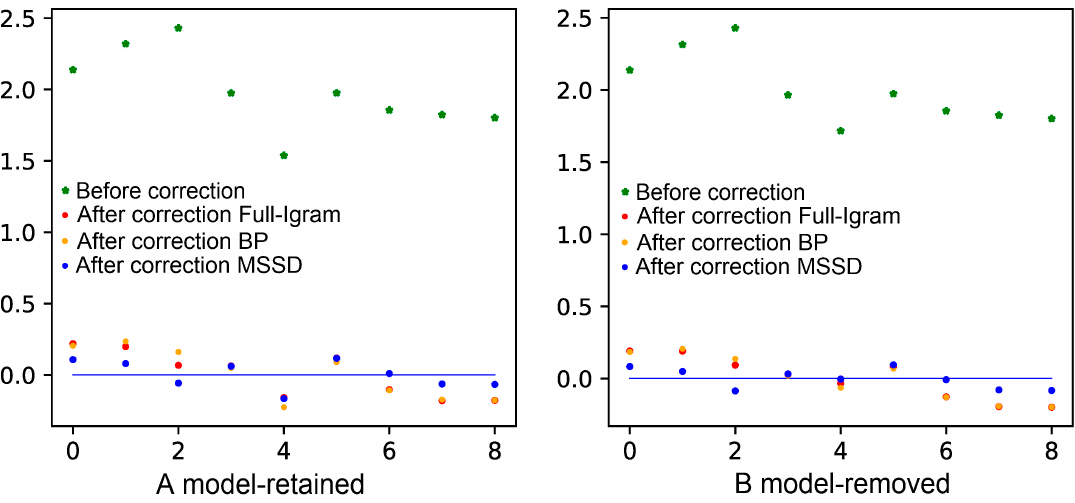
Figure 13. Correlation coe ffi cients of 9 sub-regionss: ( A ) model-retained interferogram; ( B ) the model-removed interferogram. Table 3. Correlation coe ffi cients of 9 sub-regions before model-removed.